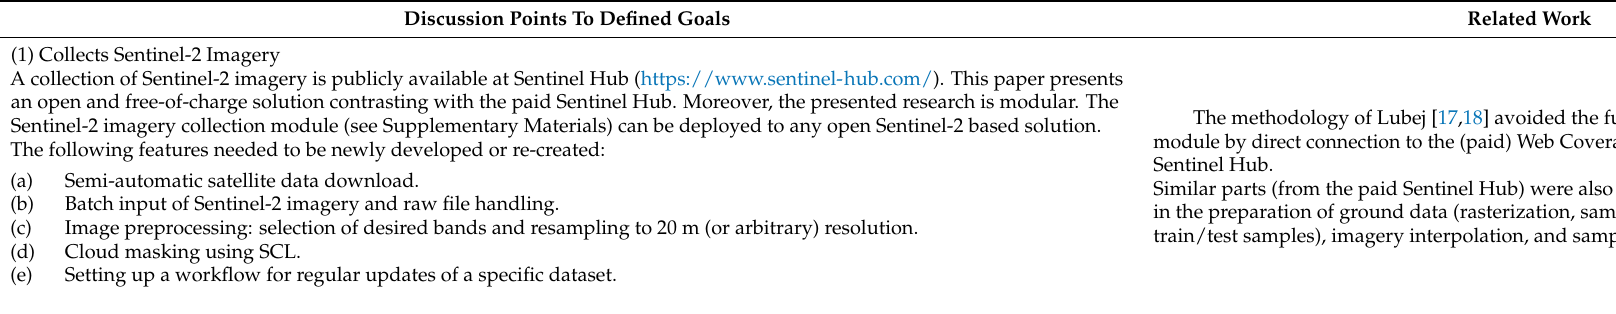
Table 4. Summary of the discussion points to the main goals of the presented paper (1–4) with respect to related work. Discussion Points To Defined Goals Related